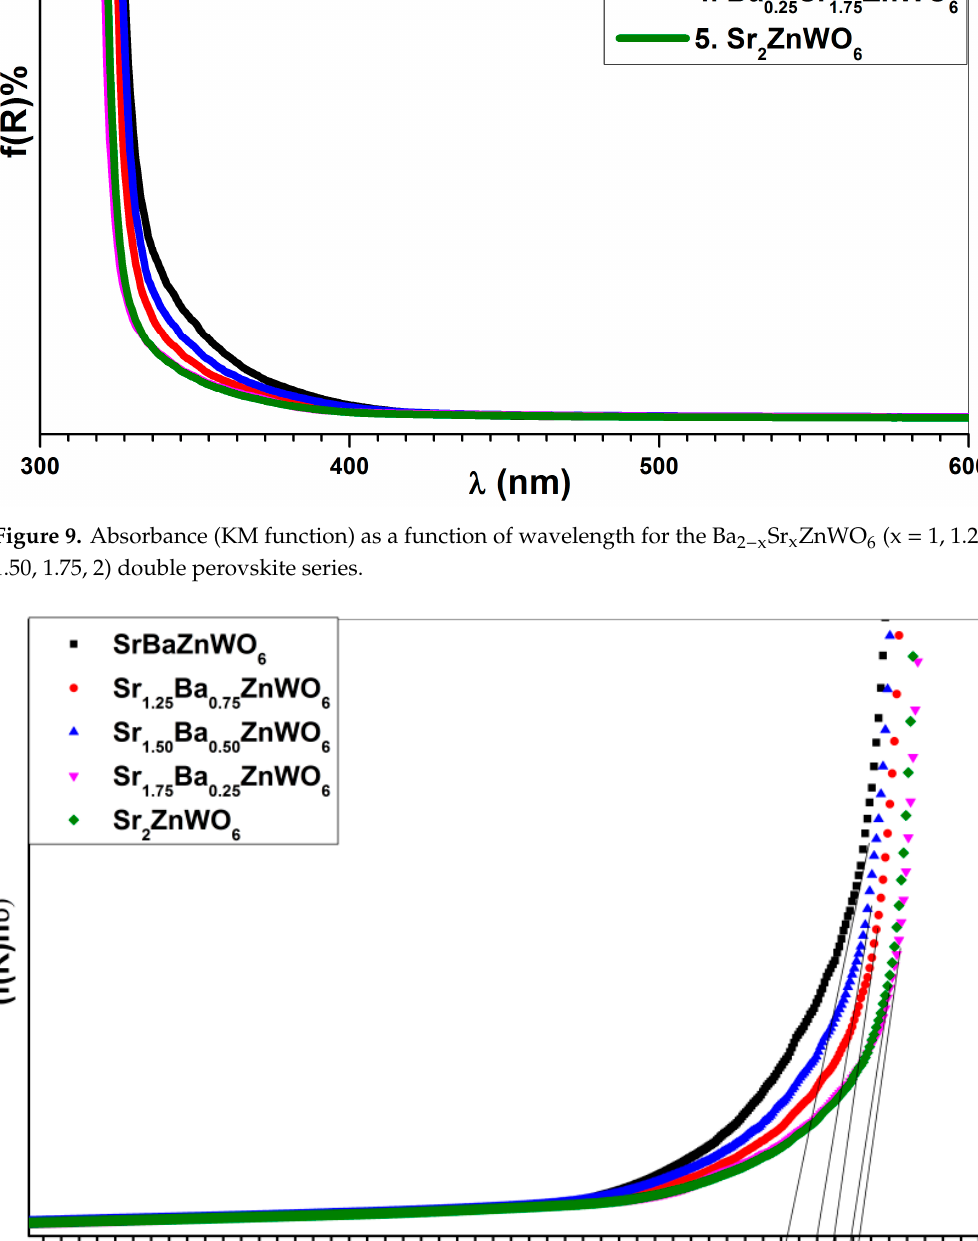
( b ) Figure 10. ( a ) Tauc plot depicting the energy band gap in the Ba 2 − x Sr x ZnWO 6 (x = 1, 1.25, 1.50, 1.75, 2) double perovskite series; ( b ) The relationship between band gap energy and ratio of Sr 2+ .